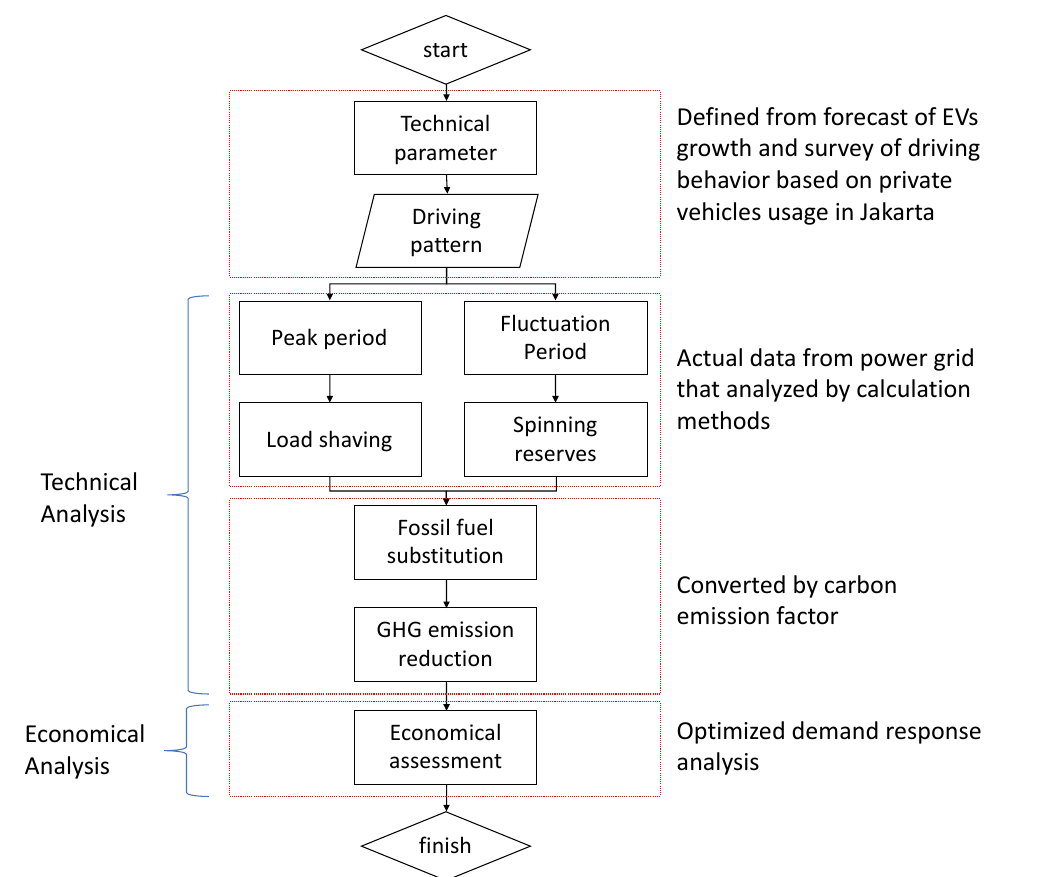
Figure 4. Conceptual diagram of techno-economic assessment for V2G implementation.